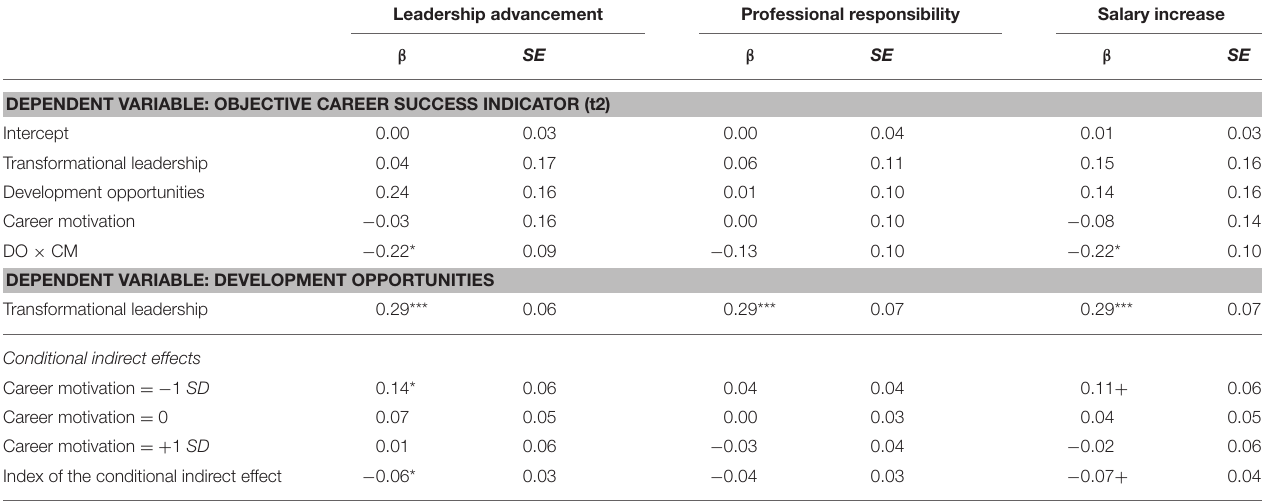
TABLE 5 | Results of the post-hoc tests ( N = 320).